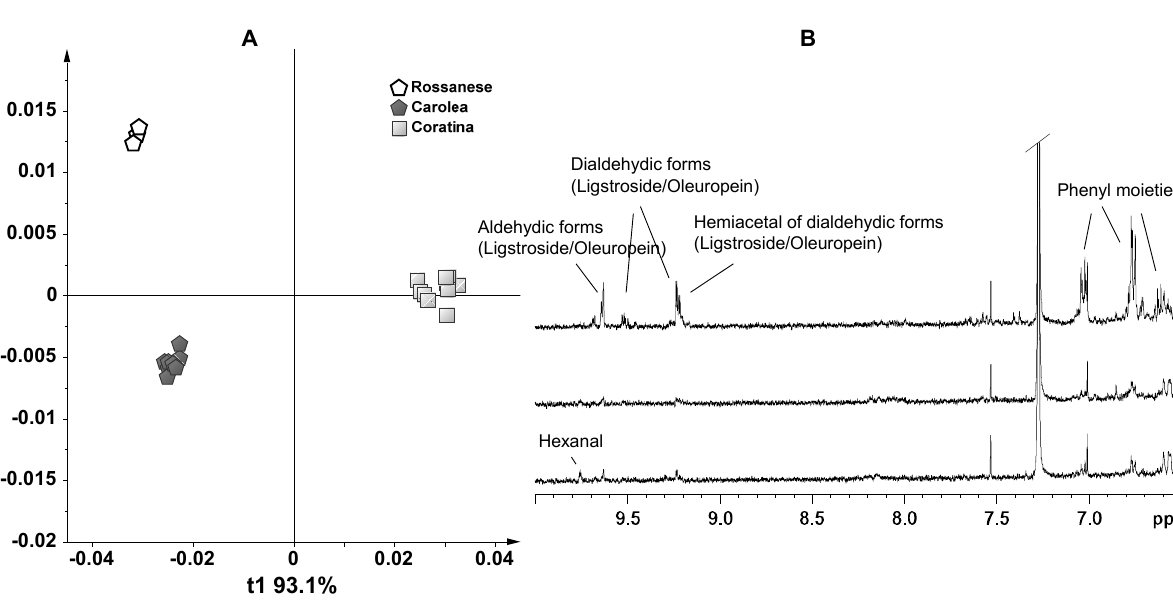
Figure 2. ( A ) PCA (t1/t2) score plot for monovarietal Coratina, Rossanese and Carolea samples (two components give R 2 = 0.97 and Q 2 = 0.95); ( B ) expansions region of the 1 H NMR spectra of monovarietal Coratina, Rossanese and Carolea samples used for the